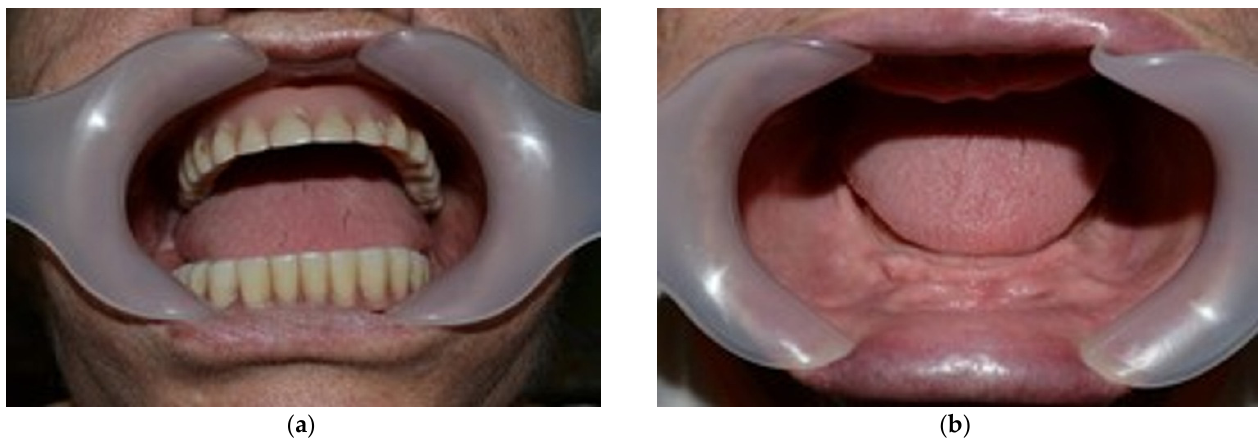
Figure 10. ( a ) protruded mandible position due to unstable and high abrasion of the artificial teeth; ( b ) appearance of the mandible prosthetic field with frontal flabby ridge.